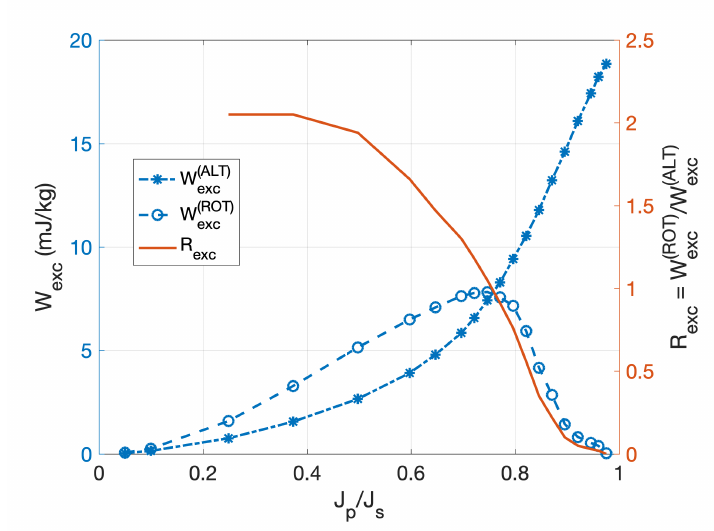
Figure 10. Behavior of the excess alternating and rotational losses versus J p / J s at 50 Hz and their ratio (experimental data retrieved from